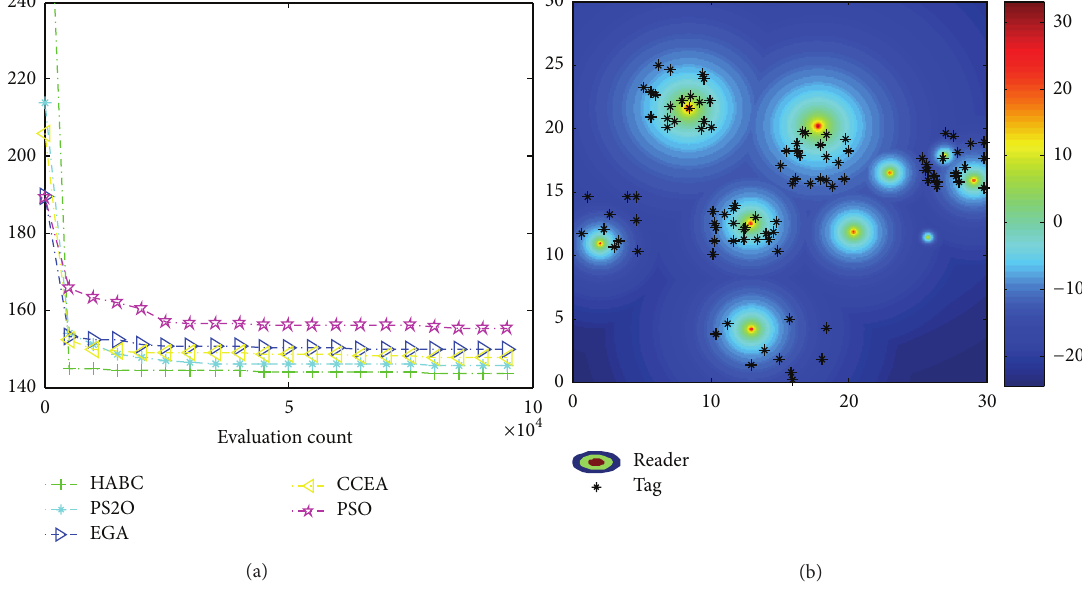
the average values obtained by HABC and other algorithms over 50 sample runs for the objective function 𝑓 𝑐 . The corresponding reader locations and the distribution of their radiated power optimized by HABC are shown in Figure